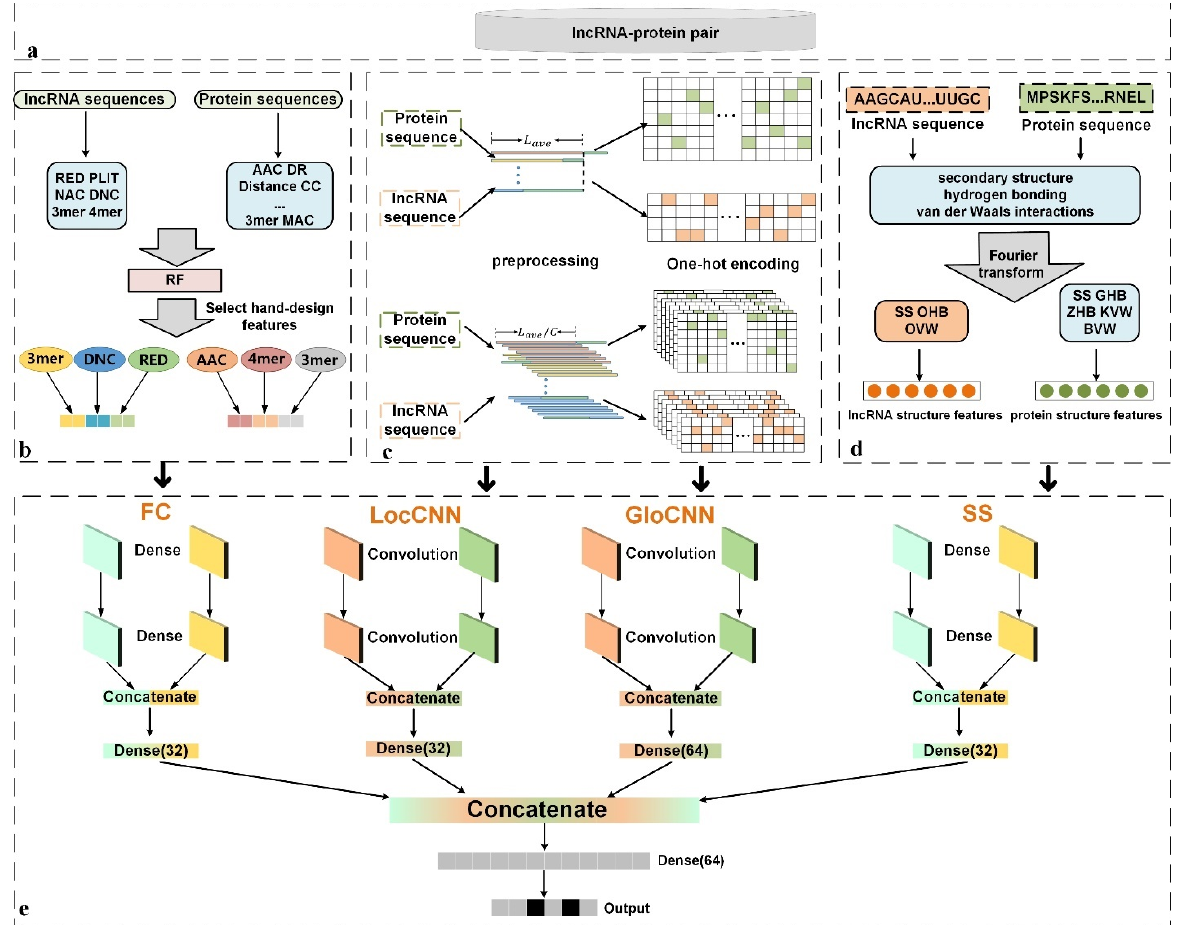
Figure 1. The flowchart of LPI-CNNCP. ( a ) Build lncRNA-protein interactions datasets and obtain lncRNA and protein sequences; ( b ) Feed lncRNA and protein hand-designed feature combinations into RF classifier to select the hand-designed features with superior predictive effect; ( c ) lncRNA and protein sequences are preprocessed by two methods and encoded by using one-hot encoding; ( d ) lncRNA and protein secondary structure, hydrogen bonding propensities, and van der Waals interactions are obtained and unifying the dimensions through Fourier transform. (e) Feed the global and local encoded sequences, hand-designed features and structure features into CNN model to predict the lncRNA-protein